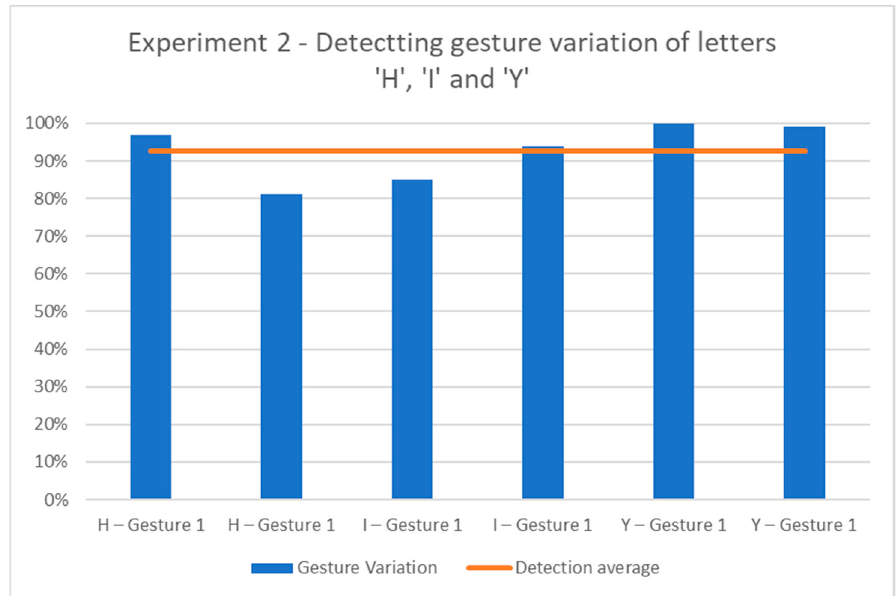
Figure 12. Variation detection accuracy of the algorithm.